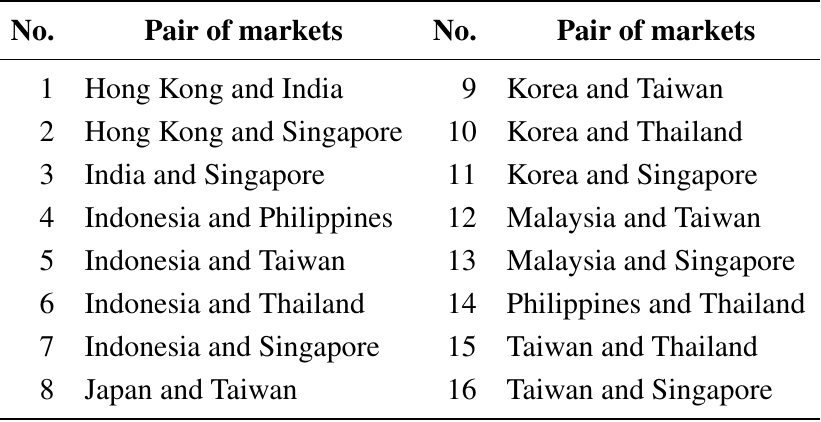
Table 15. The pairs which cannot the null hypothesis of the single common